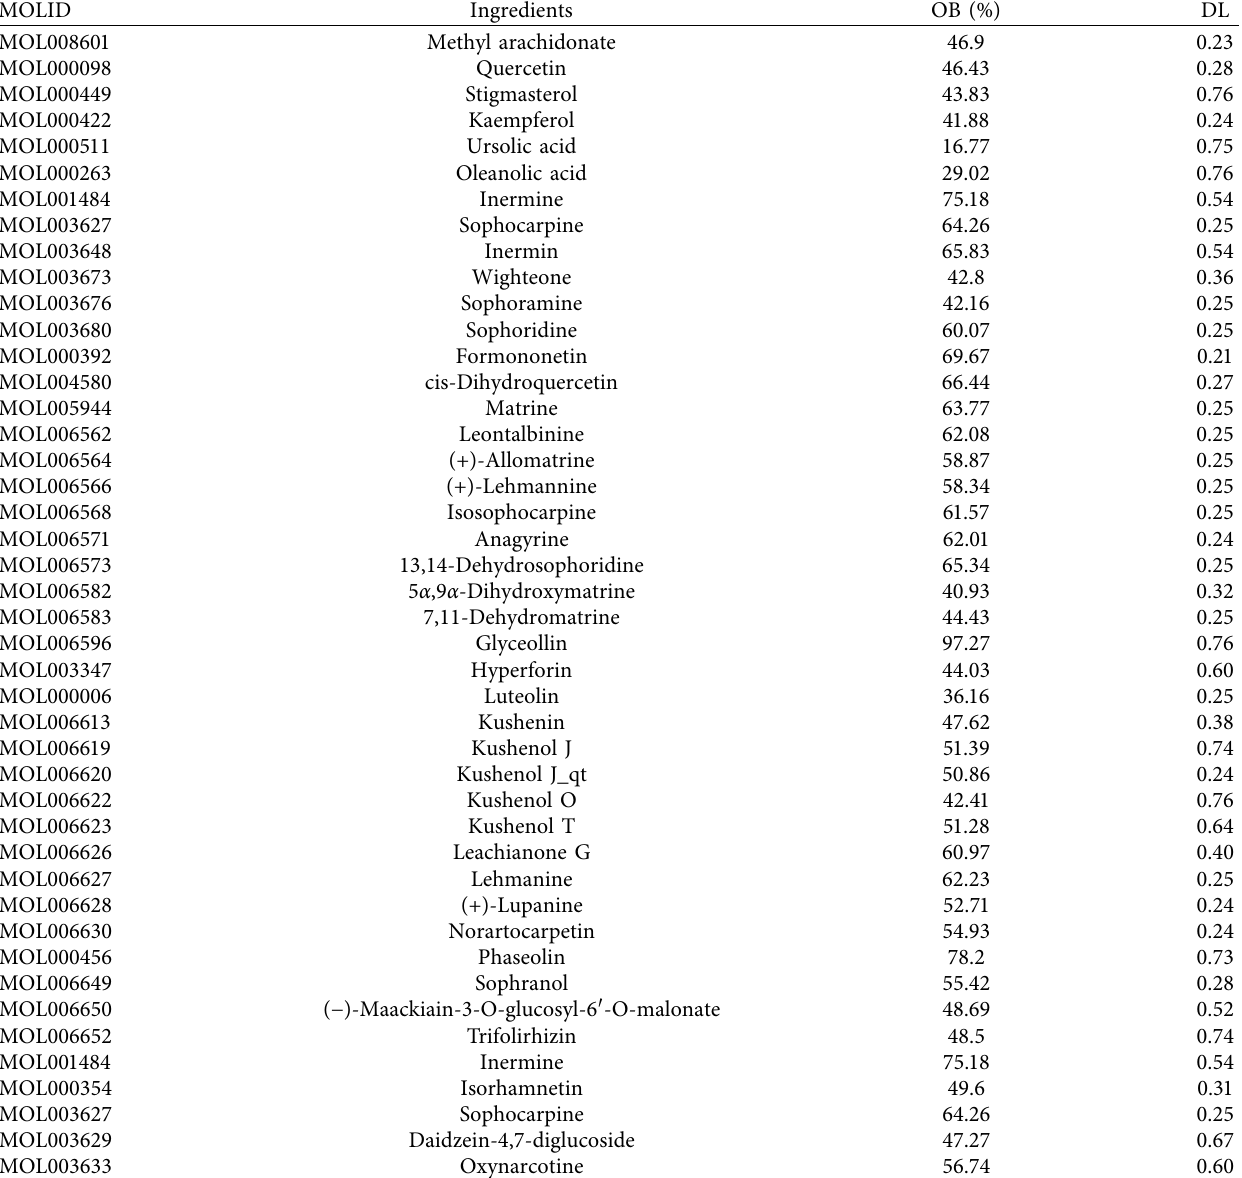
Figure 2: Venn diagram of common targets between the SLC and GC. After searching databases, 186 common targets were Table 1: Potential ingredients in SLC (OB ≥ 30%, DL ≥ 0.18).